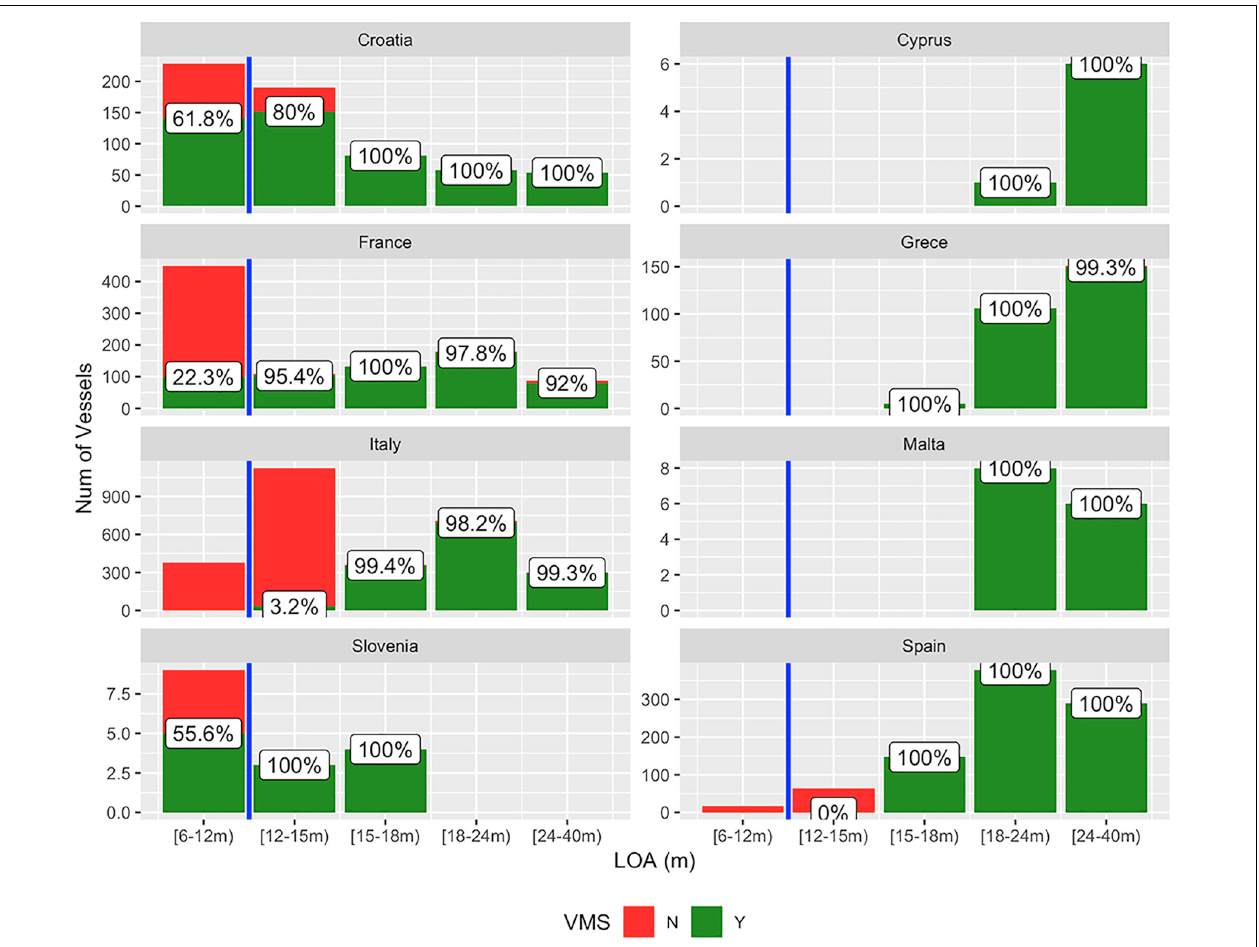
FIGURE 1 | Frequencies of the number of trawlers by country and length class equipped with the VMS (green) and without VMS (red). The percentage values represent, for each length class, the coverage of the VMS. The vertical blue line represents the legal threshold for mandatory usage of the VMS in the EU countries, although the European Council Regulation (EC) No 1224/2009 allows the member states to exempt fishing vessels in the length class [12–15 m) if they: (a) operate exclusively within the territorial seas of the flag member state; and (b) never spend more than 24 h at sea from the time of departure to the return to port). Source: official EU Community Fleet Register